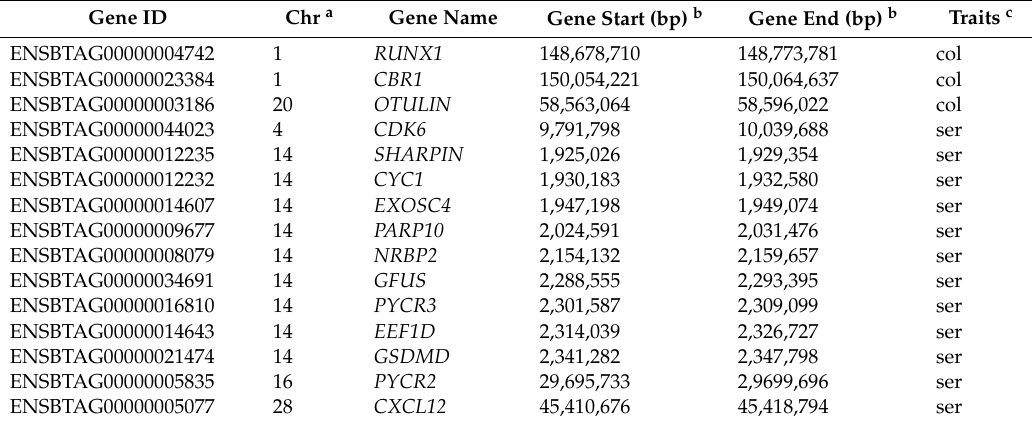
Table 3. Candidate genes 1 Mbp from the significant SNPs identified in the genome-wide association studies for the albumin concentration in colostrum and